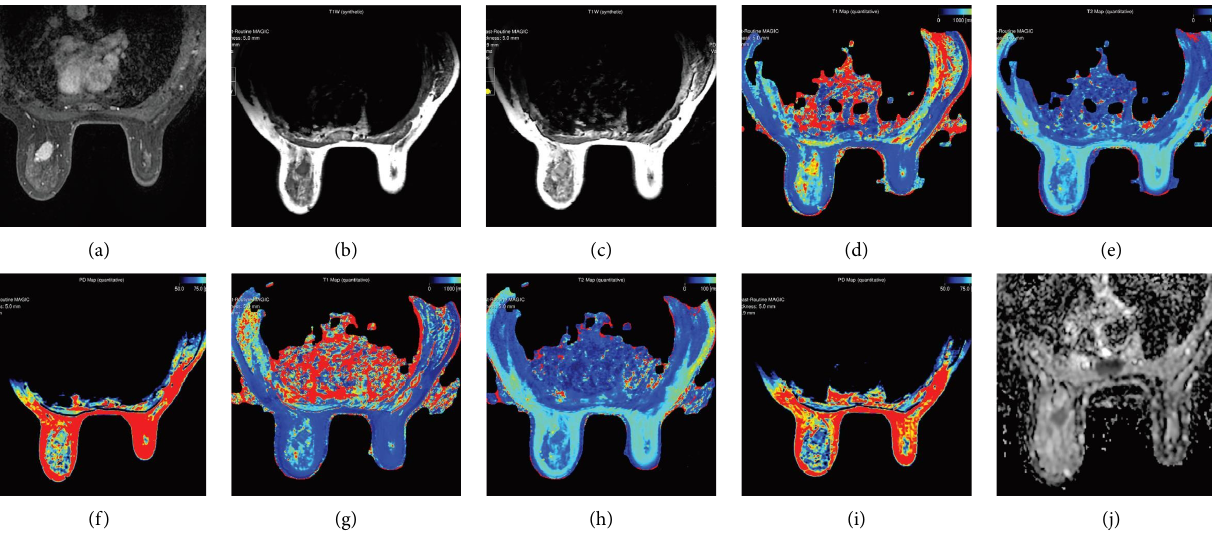
Figure 2: 47-year-old female with invasive ductal carcinoma (IDC) of the left breast. Ki-67 expression was 20%. Axial contrast enhanced T1- weighted image (T1WI) showed an irregular homogeneous enhancing mass with circumscribed margin (a) Te quantitative parameters were measured on SyMRI-T1WI before ((b) pre-T1 � 1495ms, pre-T2 � 77ms, and pre-PD � 80.8pu) and after ((c) post-T1 � 683ms, post- T2 � 69ms, and post-PD � 67.4pu) administration of the contrast medium. Similar images are shown for the mass on precontrast ((d) T1 mapping, (e) T2 mapping, and (f) PD mapping) and postcontrast ((g) T1 mapping, (h) T2 mapping, and (i) PD mapping) enhanced